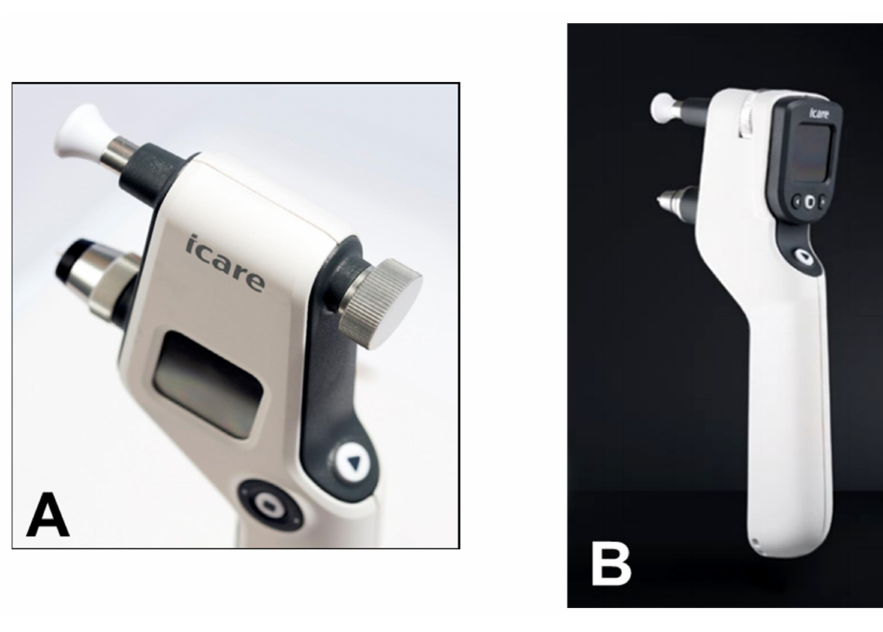
Figure 13. ( A ) iCare 100; ( B ) iCare 200 version.